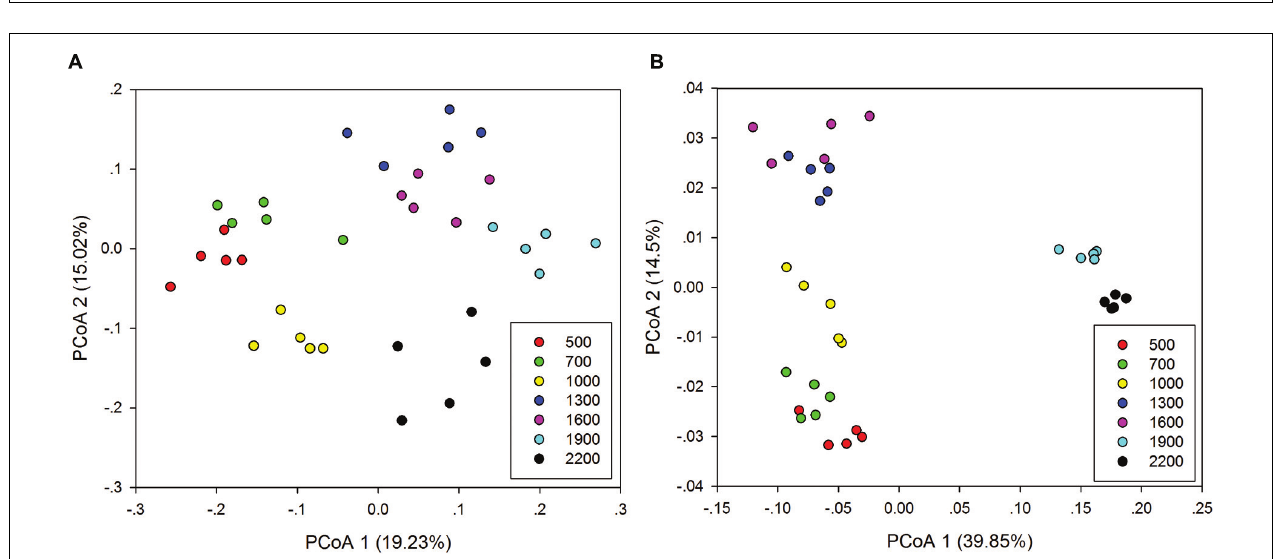
FIGURE 4 | Principal co-ordinates analysis (PCoA) of the bacterial community composition (A) and microbial functional gene composition